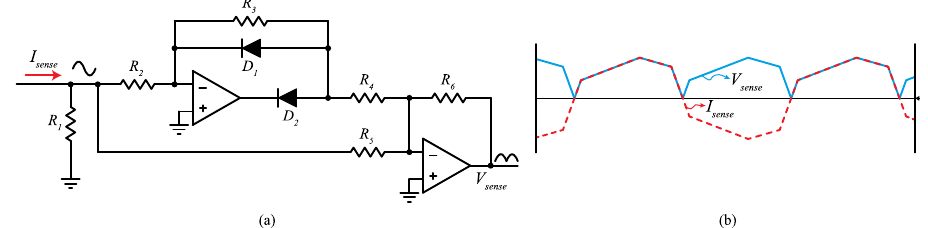
Figure 12. Absolute-value detection method; ( a ) Circuit diagram, ( b ) Output waveform. .